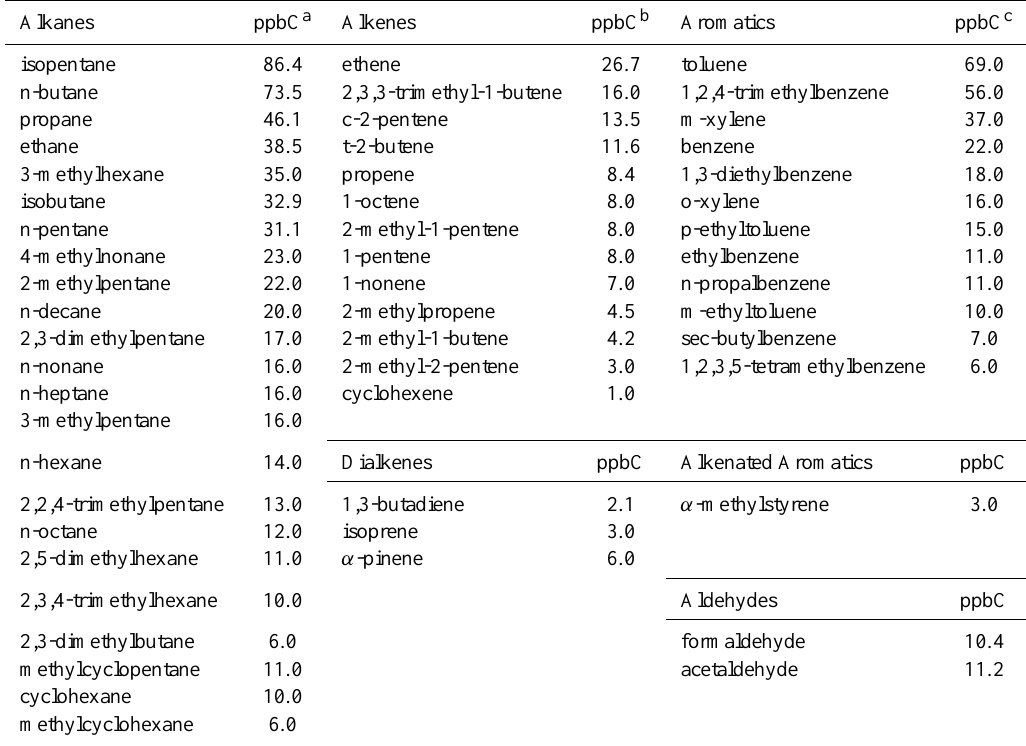
Table 1. Chemical Composition d of Synthetic Urban VOC Mixture, SynUrb54 (Jeffries et al.,